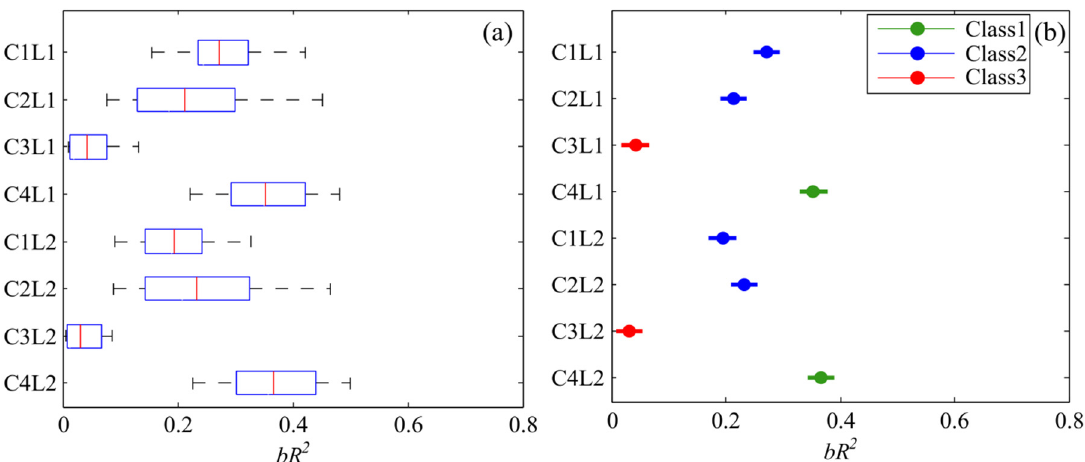
Figure 3. ( a ) The performance of the eight configurations in simulating discharge before calibration (single model run). Red lines show the average bR 2 obtained from the nine outlets and the boxes show the 25th and 75th percentiles and the whiskers show the maximum and minimum. ( b ) The three performance classes obtained from the multiple comparison significance test before calibration. The dots show the average bR 2 and the ranges indicate the standard error.